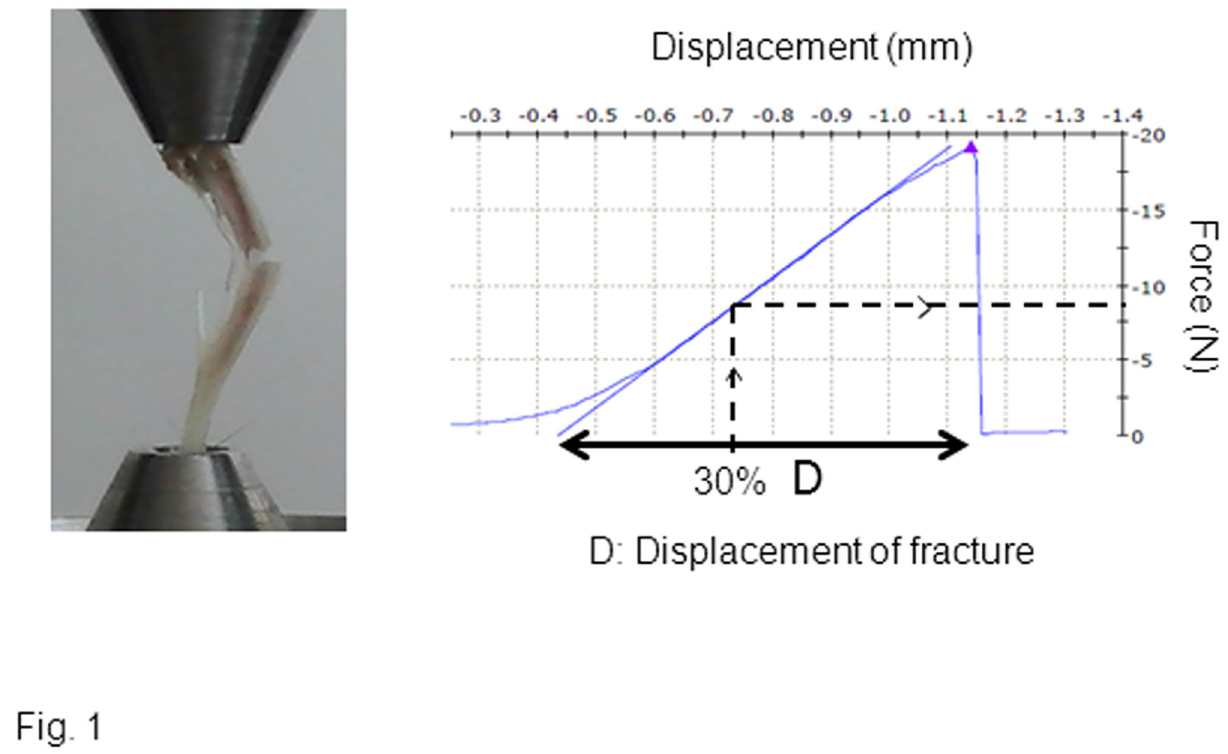
Figure 1. Axial compression of the full tibia. The mechanical resistance to failure was tested in pilot experiments to determine the loads which will be applied in vivo to induce damage [15] The force compression threshold for fatigue loading was determined as a displacement that reached 30% of the average displacement to complete fracture in Postn +/+ mice (D). doi: